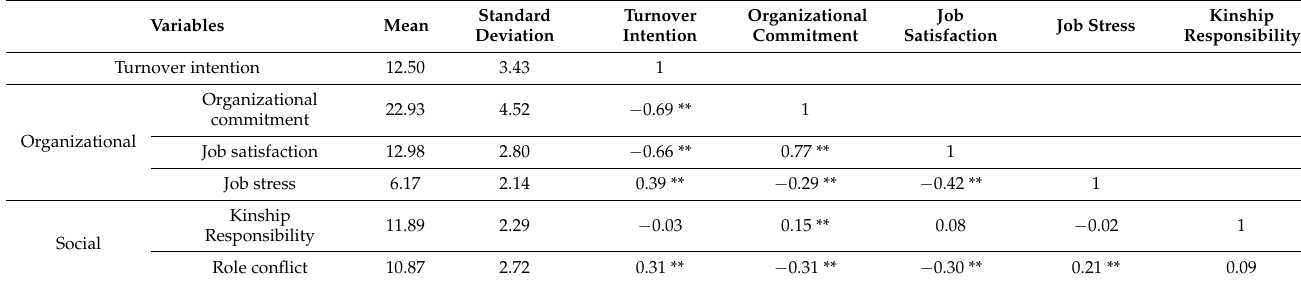
Table 2. Descriptive statistics and correlations ( N = 306).